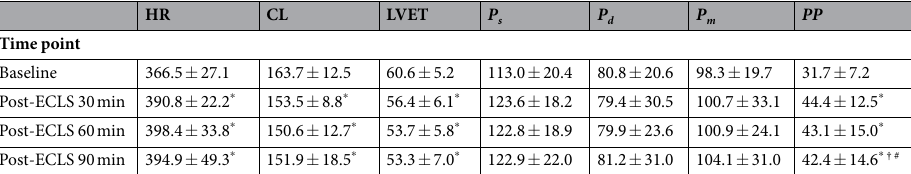
Table 1. Basic hemodynamic data measured in rats at baseline and at 30, 60, and 90 min post-ECLS. Variables are expressed as median ± interquartile range (IQR). HR = heart rate (beats min − 1 ); CL = cardiac cycle length (ms, which means the duration of single beat); LVET = left ventricular ejection time (ms, which was derived from the duration of the first two vertical lines in Fig. 1A–D); P s = systolic pressure (mmHg); P d = diastolic pressure (mmHg);